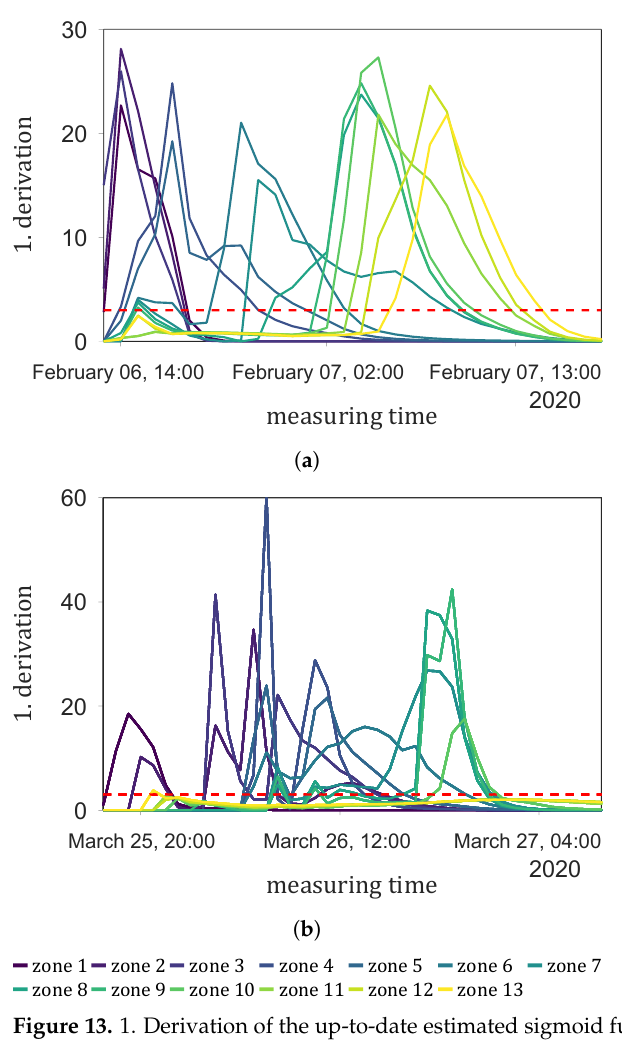
Figure 13. 1. Derivation of the up-to-date estimated sigmoid function for the melting processes from ( a ) Figure 6 and ( b ) Figure